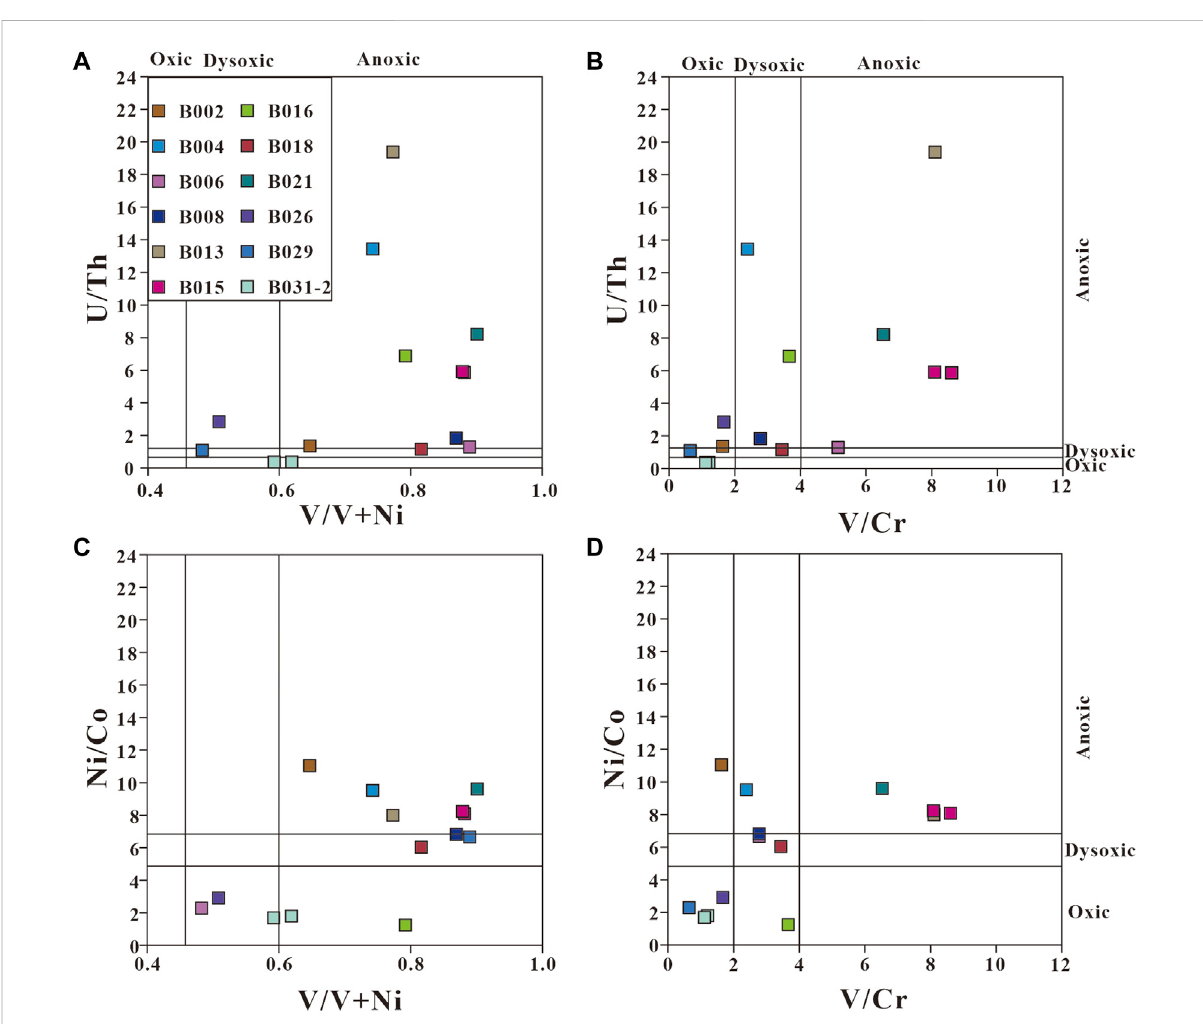
FIGURE 6 Crossplots of Ni/Co, V/Cr and U/Th ratios of samples of the Dalong Formation takin in Longfeng Quarry, Northwest Township, Guangyuan. (A) U/Th vs . V/(V + Ni). (B) U/Th vs . V/Cr. (C) Ni/Co vs . V/(V + Ni). (D) Ni/Co vs .